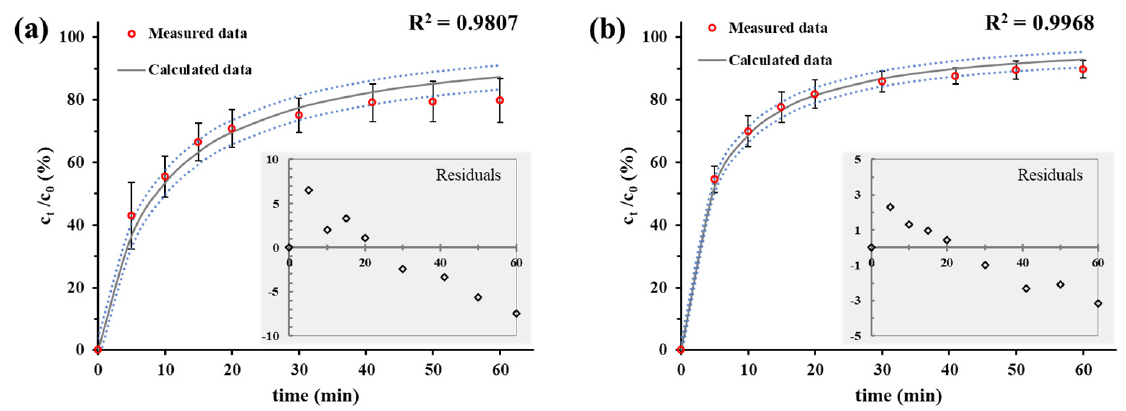
Figure 6. The in vitro dissolution profiles (empty red circles) of liposomal B 1 with the calculated non-linear second-order kinetic model-based release curves (continuous lines) in ( a ) PBS and ( b ) artificial gastric juice.